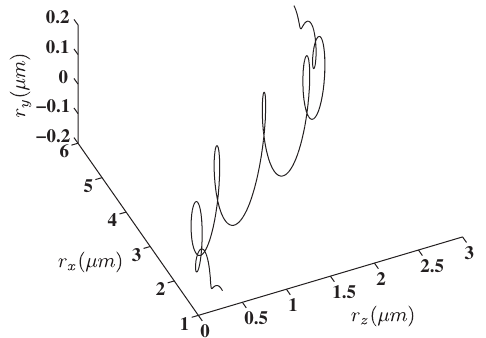
FIG. 9. The electron trajectory during the interaction. All of the calculation parameters are the same as those in Fig.